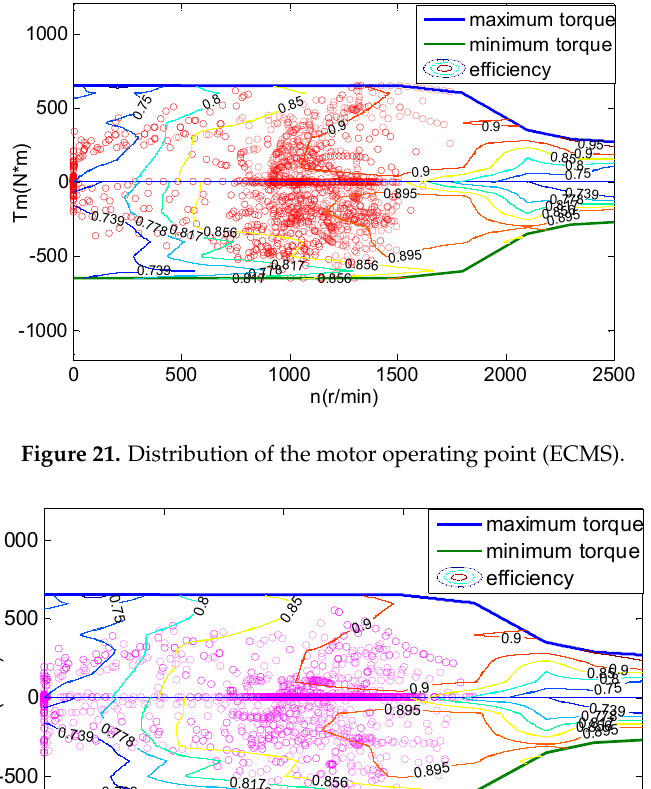
Figure 21. Distribution of the motor operating point (ECMS).